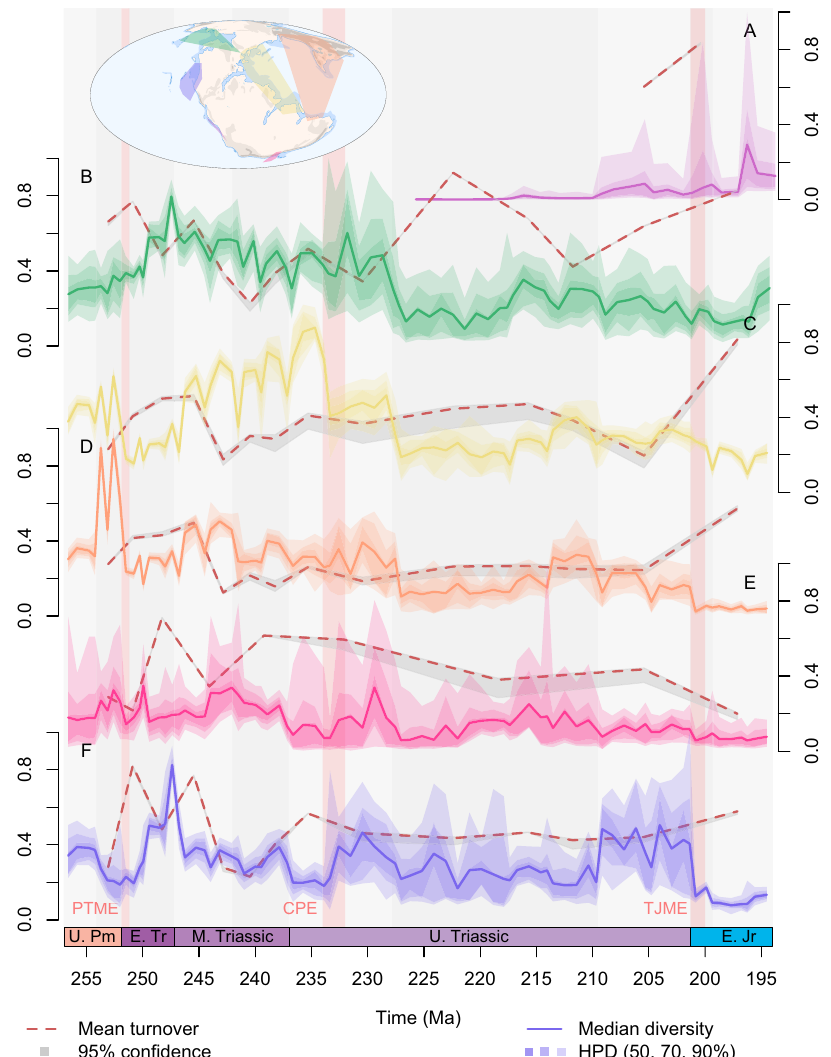
Fig. 4 Regional probabilistic diversity curves, their 50%, 75% and 95% highest posterior densities (HPD), and median turnover with 95% con fi dence intervals. Diversity trajectories and magnitude of turnover, differ substantially between different parts of the globe and across key biotic upheavals highlighted with red bars: the end-Permian mass extinction (PTME), Carnian Pluvial Episode (CPE), and end-Triassic mass extinction (TJME). Full uncertainty intervals for the diversity estimates are displayed here, but show that the median diversity trends presented in Fig. 2 are representative of these uncertainties. As in Fig. 2, displayed results are derived from datasets standardised by minimum spanning tree length. All diversity values are rescaled so that the highest value in each 95% con fi dence interval is equal to 1. Each turnover value and con fi dence interval record the relative abundance-corrected Forbes* dissimilarity relative to the preceding bin. A South Panthalassic. B Boreal. C West Circumtethys. D East Circumtethys. E Tangaroan. F North Panthalassic. Source data are provided as a Source Data fi